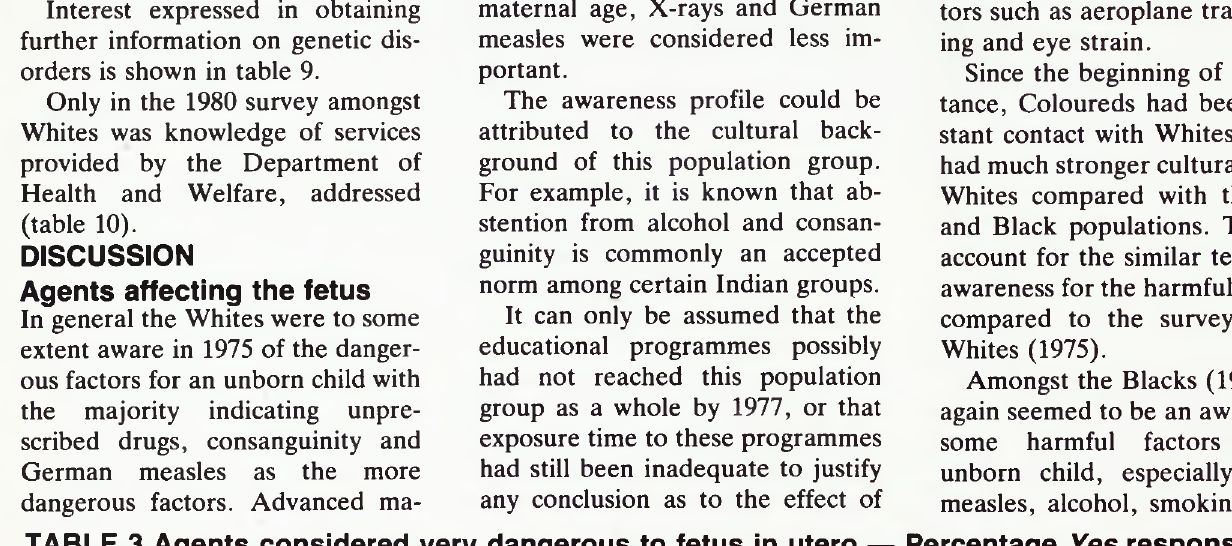
TABLE 3 Agents considered very dangerous to fetus in utero — Percentage Yes responses